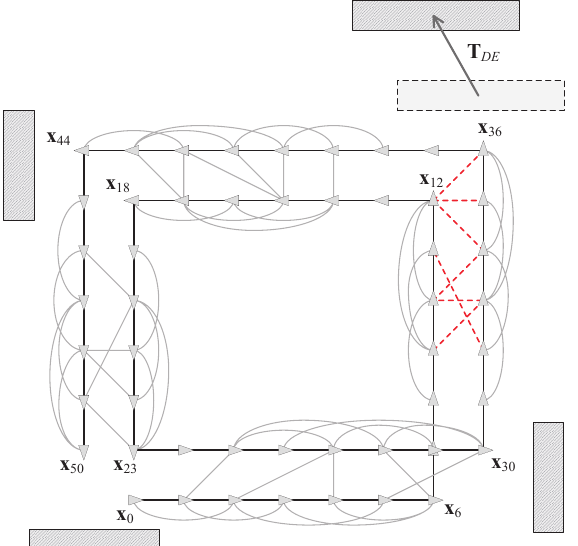
Figure 6. Example of pose graph SLAM in a low dynamic